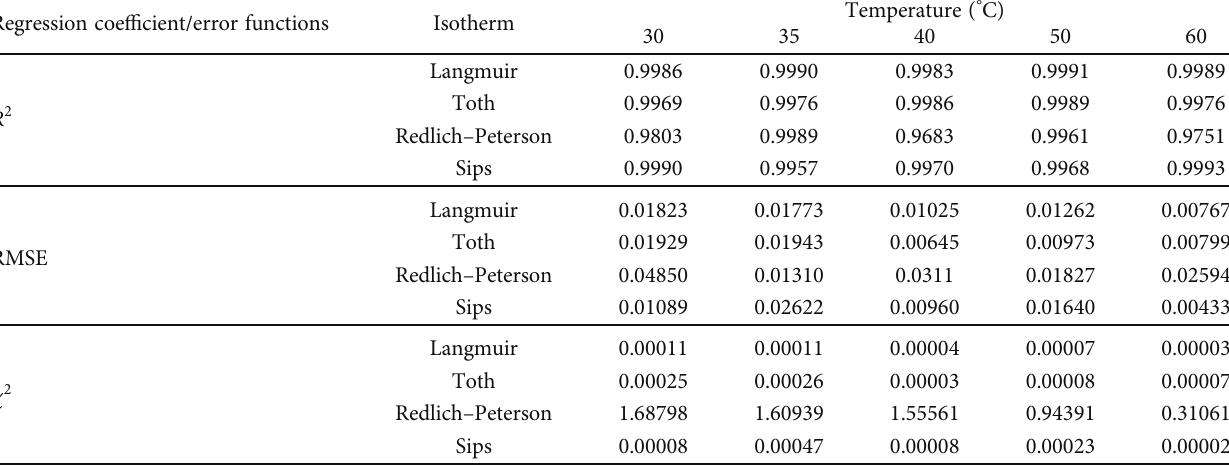
Table 3: Comparison of the regression coe ffi cient ( R 2 ), root-mean-square error (RSME), and Chi-squared test ( χ 2 ) isotherm